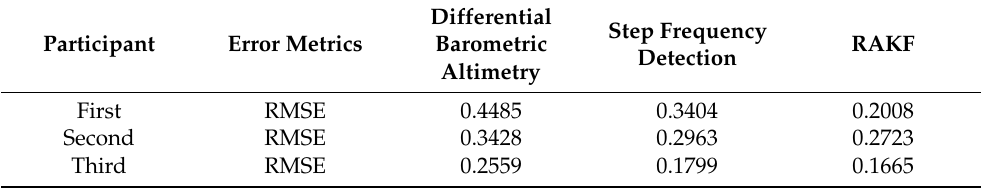
Table 2. Statistical results of height error in the test